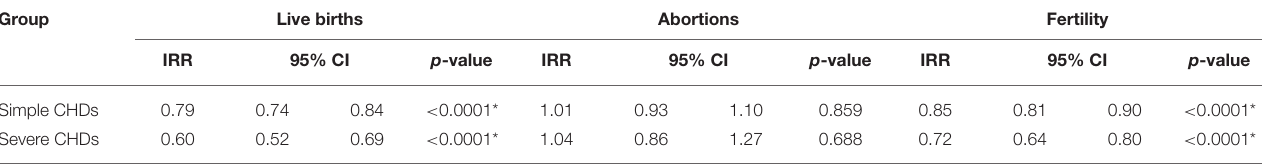
TABLE 4 | The influence of different cardiac structural defects on live births, abortions, and fertility.